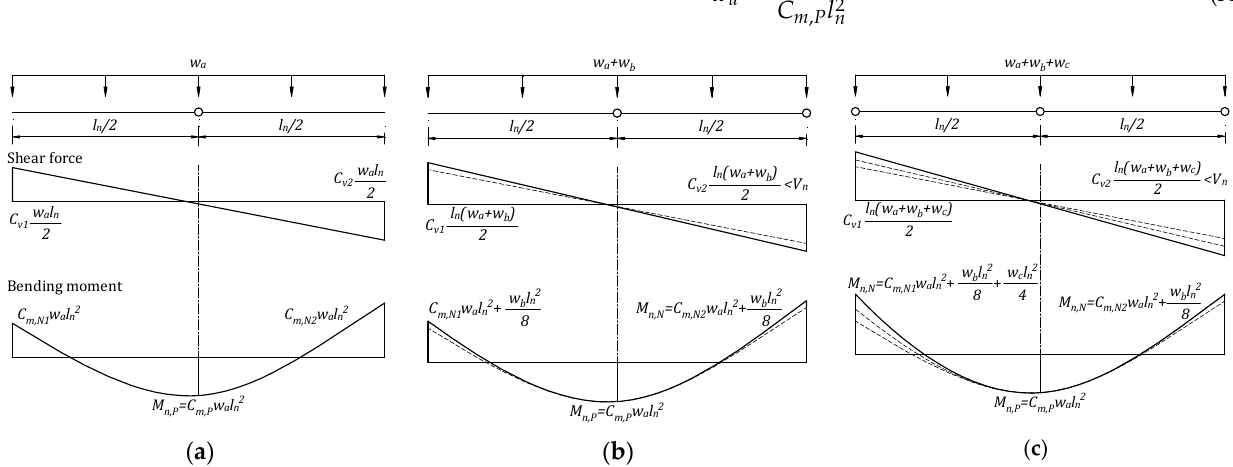
Figure A5. Failure mechanism for D-3 region. ( a ) Flexural failure at the mid-span section first; next, ( b ) flexural failure at the N2 section; and finally, ( c ) flexural failure at the N1 section.